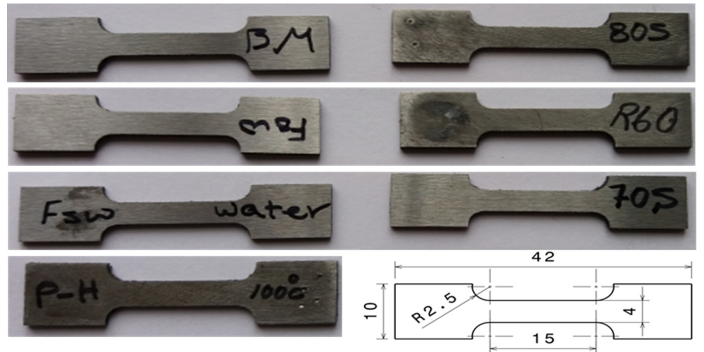
Figure 2. Scheme of tensile specimens welded through both FSW and